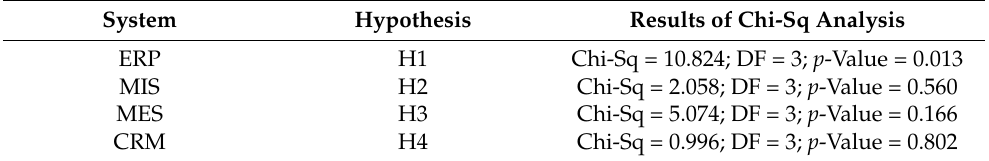
Table 2. Results of Chi-Sq analysis for ERP, MIS, MES, and CRM systems depending on company size (Large, Medium, Small,